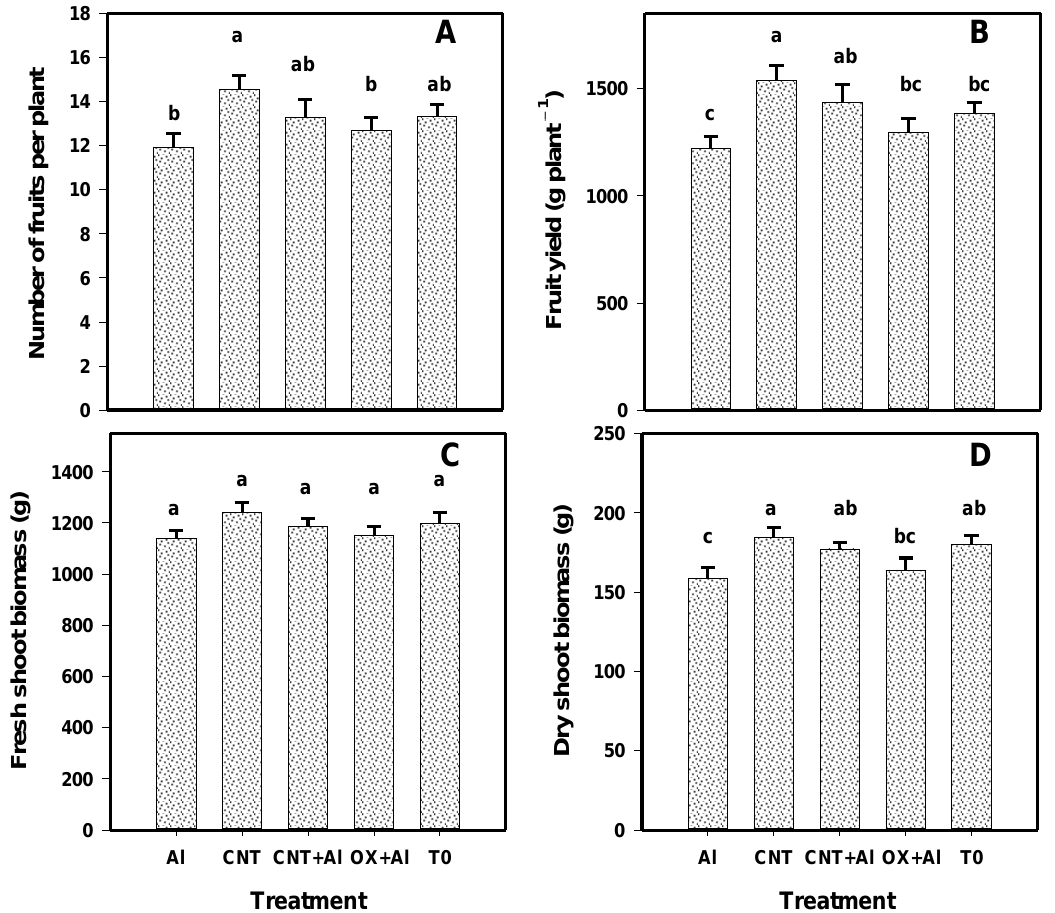
Figure 3. Number of fruits per plant ( A ), fruit yield ( B ), fresh shoot biomass ( C ), and dry shoot biomass ( D ) of tomato crop. Al: Positive control inoculated with A. solani ; CNT: Carbon nanotubes; OX: Commercial control; T0: Control. Different letters indicate significant differences between treatments according to the least significant difference of Fisher test ( α = 0.05). N = 5 ± standard error.